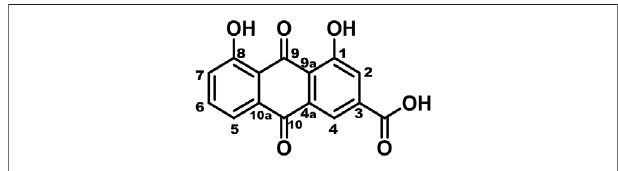
FIGURE 1 | The chemical structure of